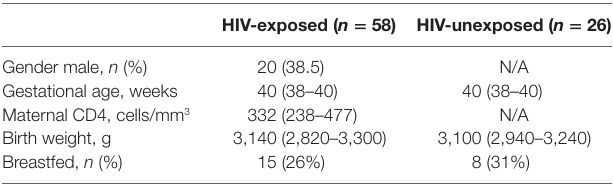
Table 1 | Demographics of study participants in each